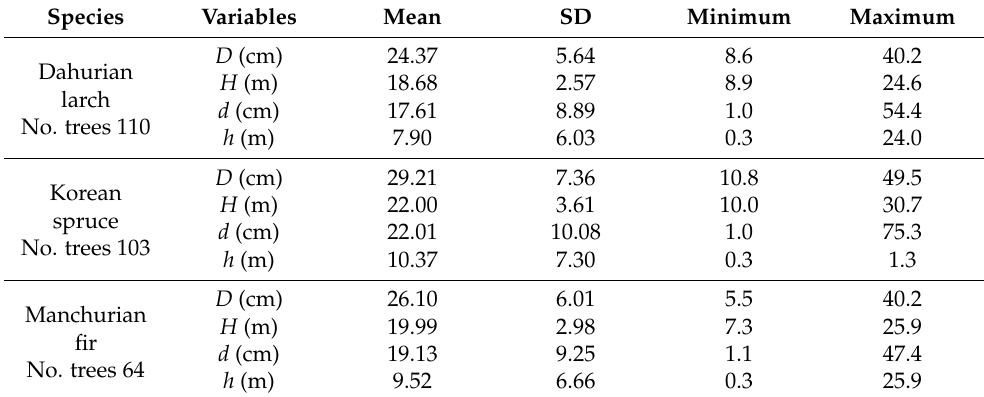
Table 1. Summary statistics for the tree species